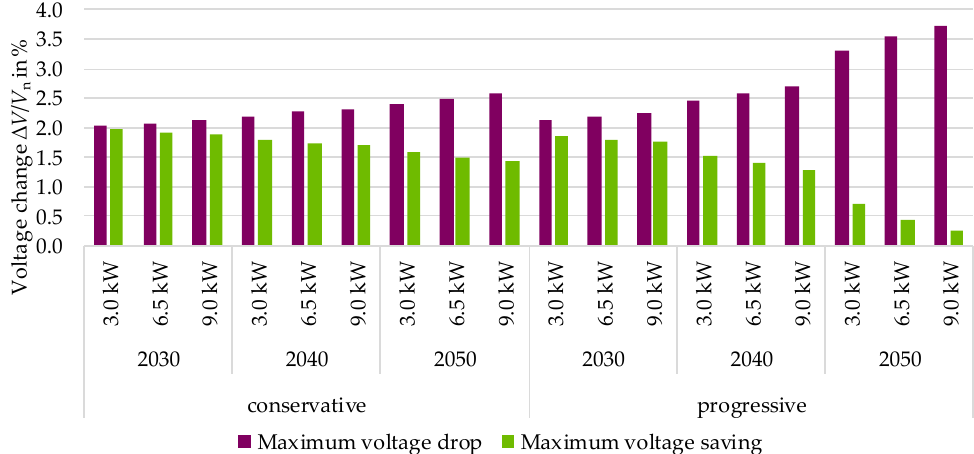
Figure 21. Maximum voltage drop and maximum voltage saving consolidated over eleven MV grids for the two development scenarios over three years until 2050 based on [59].